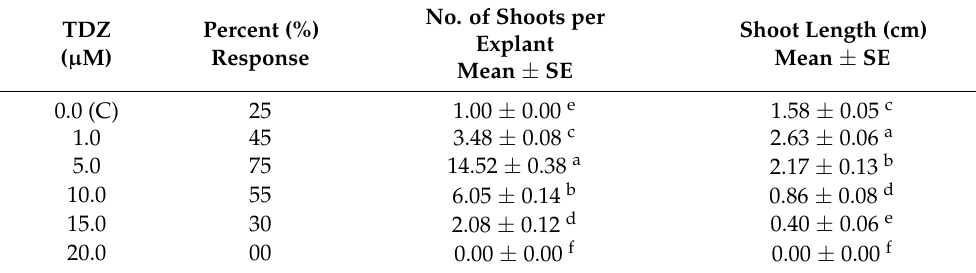
Table 1. Primary (or wide) screening of TDZ on multiple shoot induction from node explants of L. speciosa after 4 weeks of